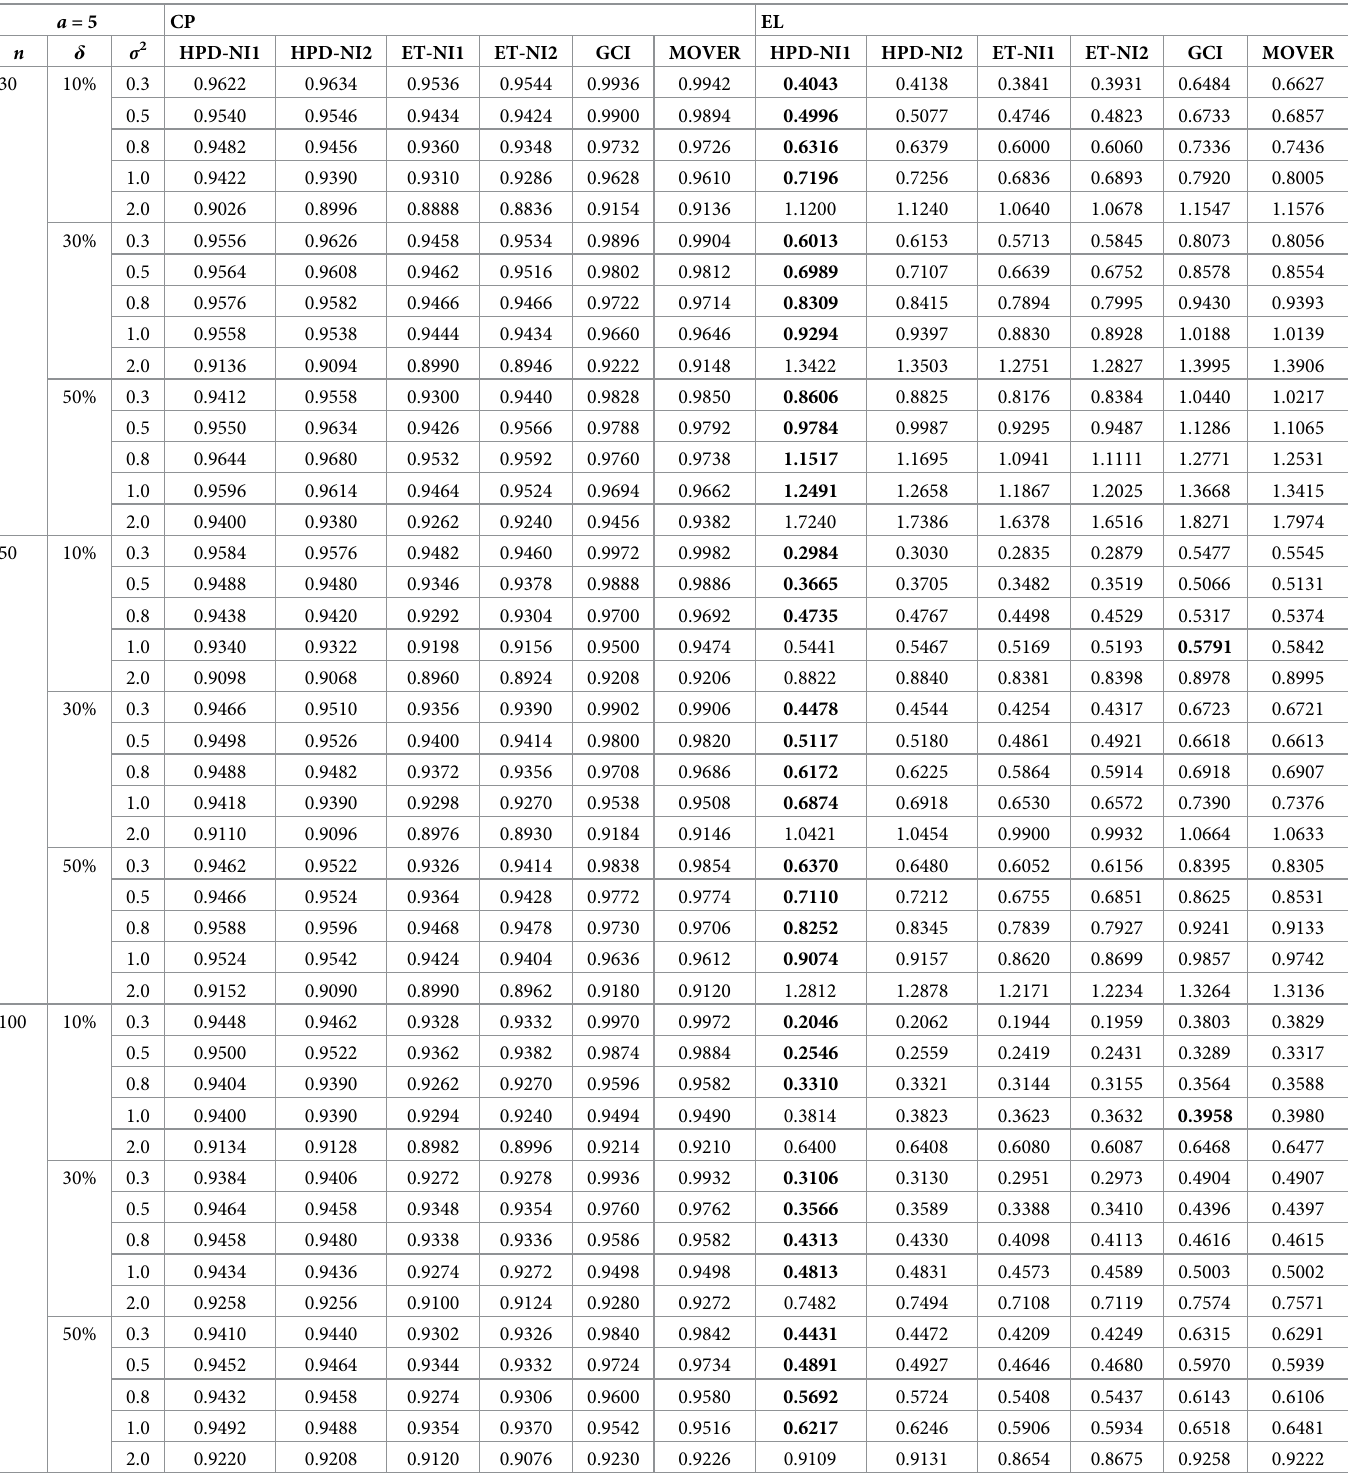
Table 2. CP and EL performances of 95% CI for θ : a =